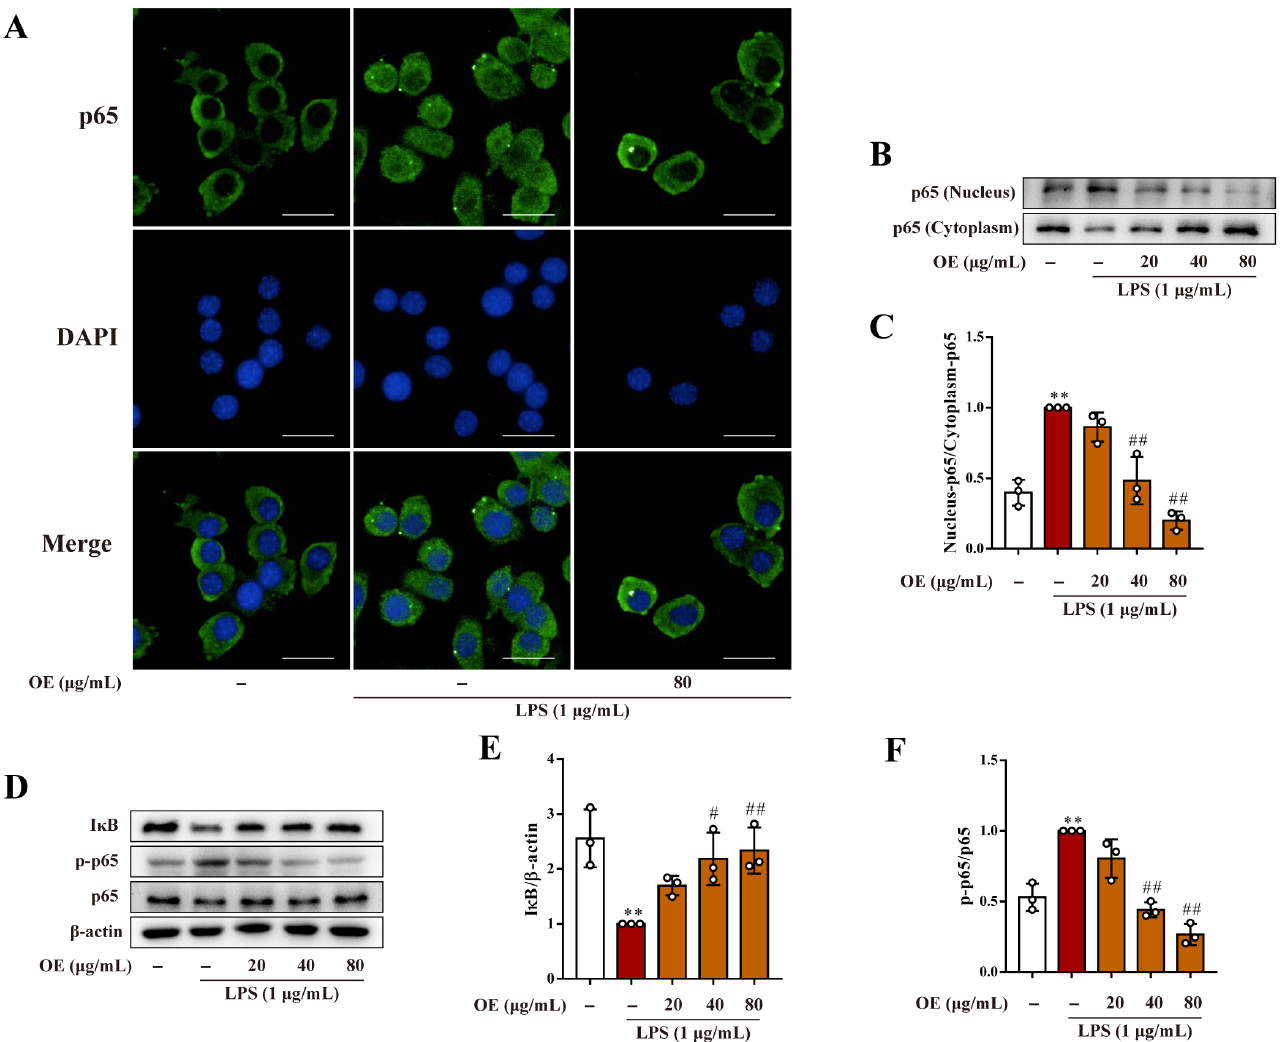
Figure 2. OE suppressed NF- κ B activation in macrophages. ( A ) RAW264.7 macrophages were pre- treated with OE (80 μ g/mL) for 3 h followed by stimulation with LPS (1 μ g/mL) for 2 h. p65 nuclear translocation was detected by immunofluorescent staining. Scale bars: 20 μ m. ( B – F ) RAW264.7 macrophages were pretreated with OE (20, 40, 80 μ g/mL) for 3 h followed by LPS (1 μ g/mL) stimulation for 2 h. Nuclear and cytoplasmic protein expression of p65 ( B , C ) and the protein expression level of I κ B, p-p65, and p65 ( D – F ) were determined by a western blotting assay. Data presented as Means ± SD., ** p < 0.01 vs. control group; # p < 0.05, ## p < 0.01 vs. LPS group; ns, no significance.